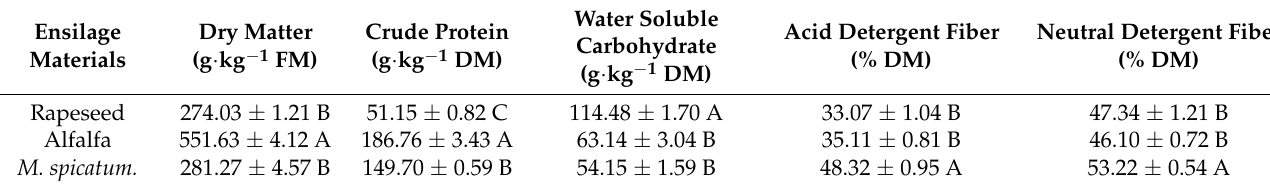
Table 1. Chemical composition of silage raw